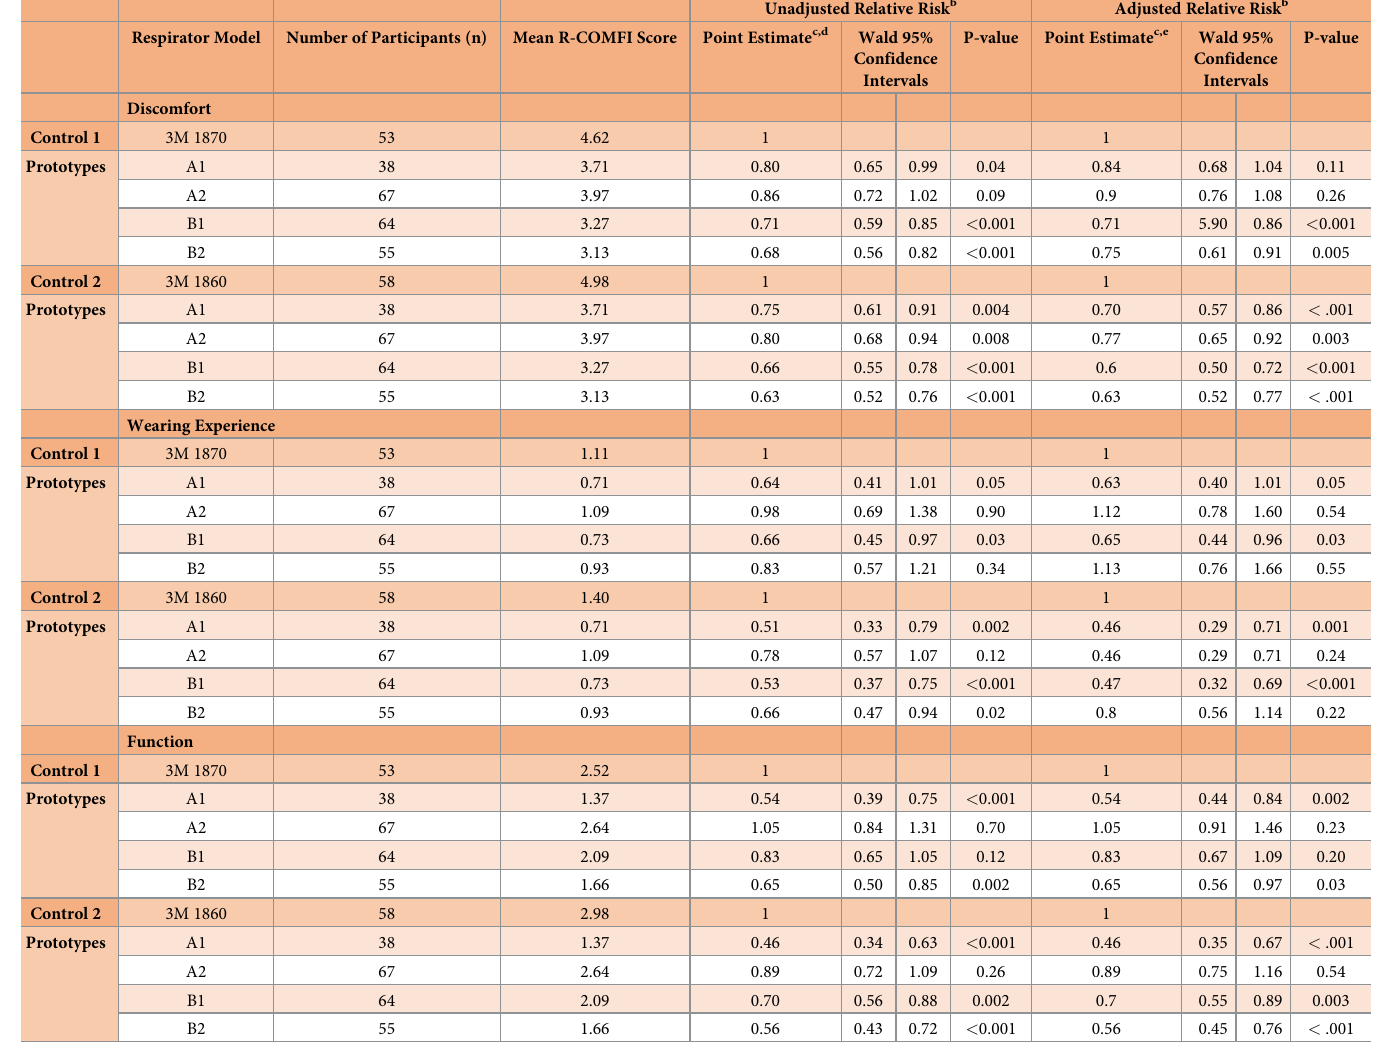
Table 5. Subscale R-COMFI scores a for prototype respirators compared to control